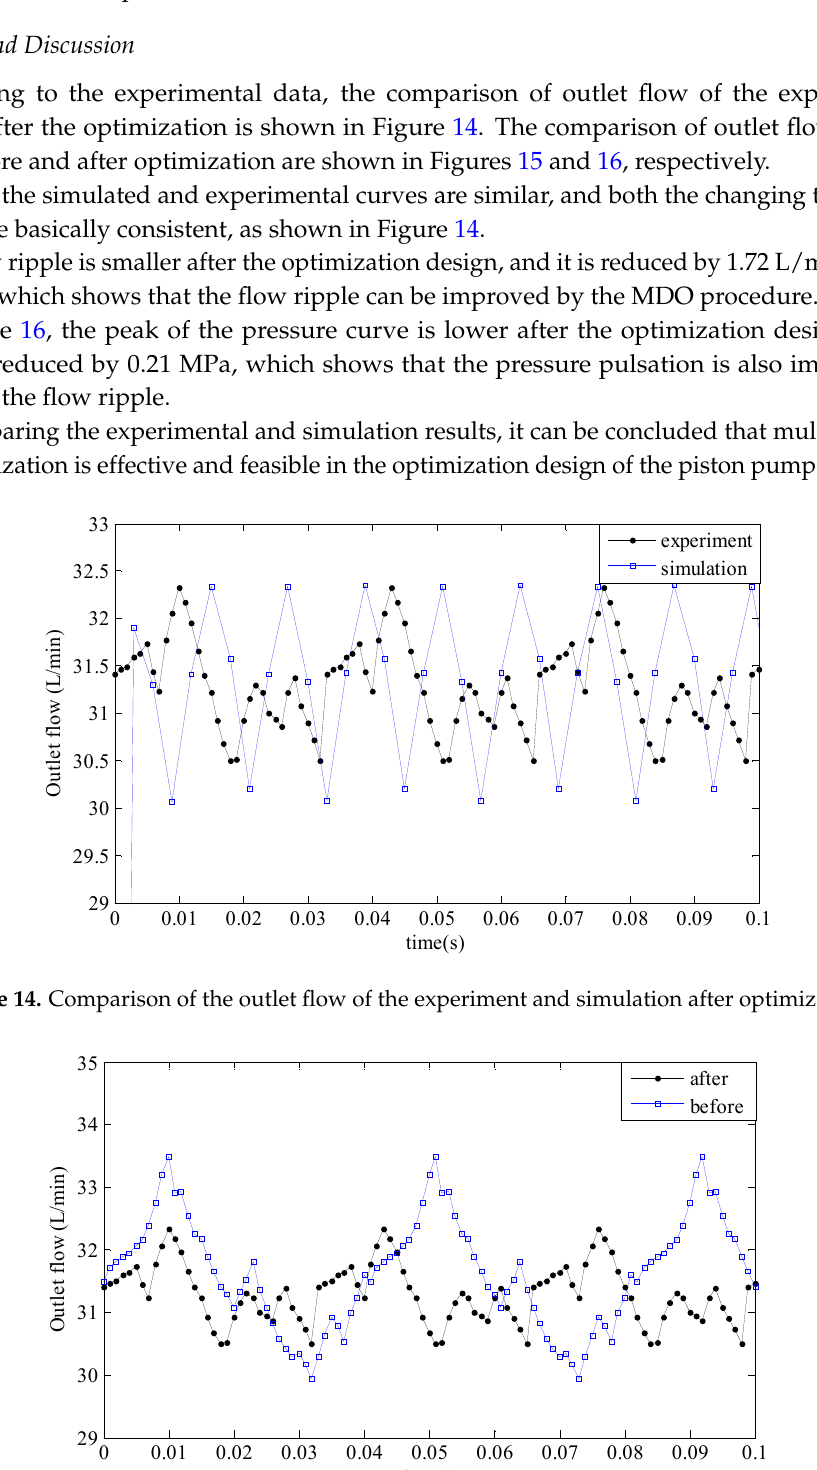
Figure 13. Experimental hydraulic circuit.